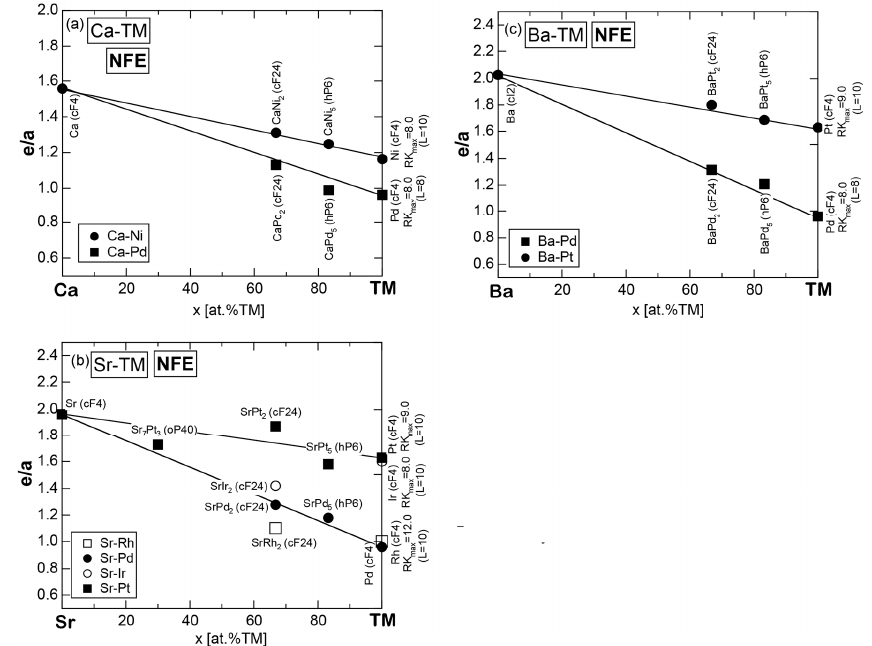
Figure 97. Composition dependence of e/a for intermetallic compounds and pure elements in ( a ) Ca– TM (TM = Ni, Pd), ( b ) Sr–TM (TM=Rh, Pd, Ir, Pt) and ( c ) Ba-TM (TM=Pd, Pt) alloy systems [37]. The